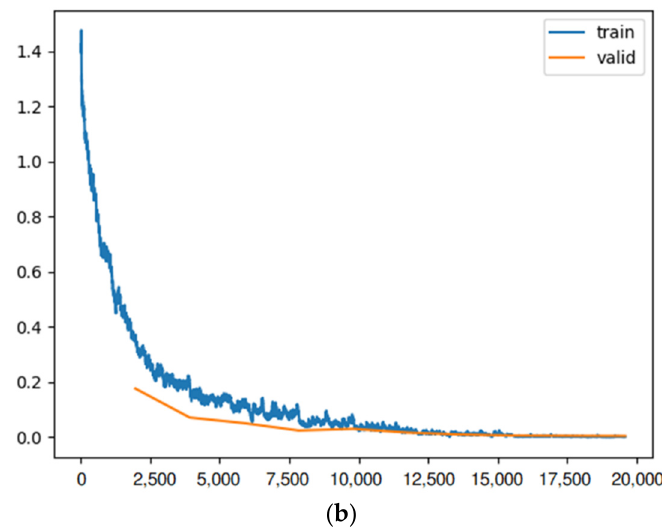
Figure 22. ( a ) Confusion matrix and ( b ) loss rate during training with AlexNet.